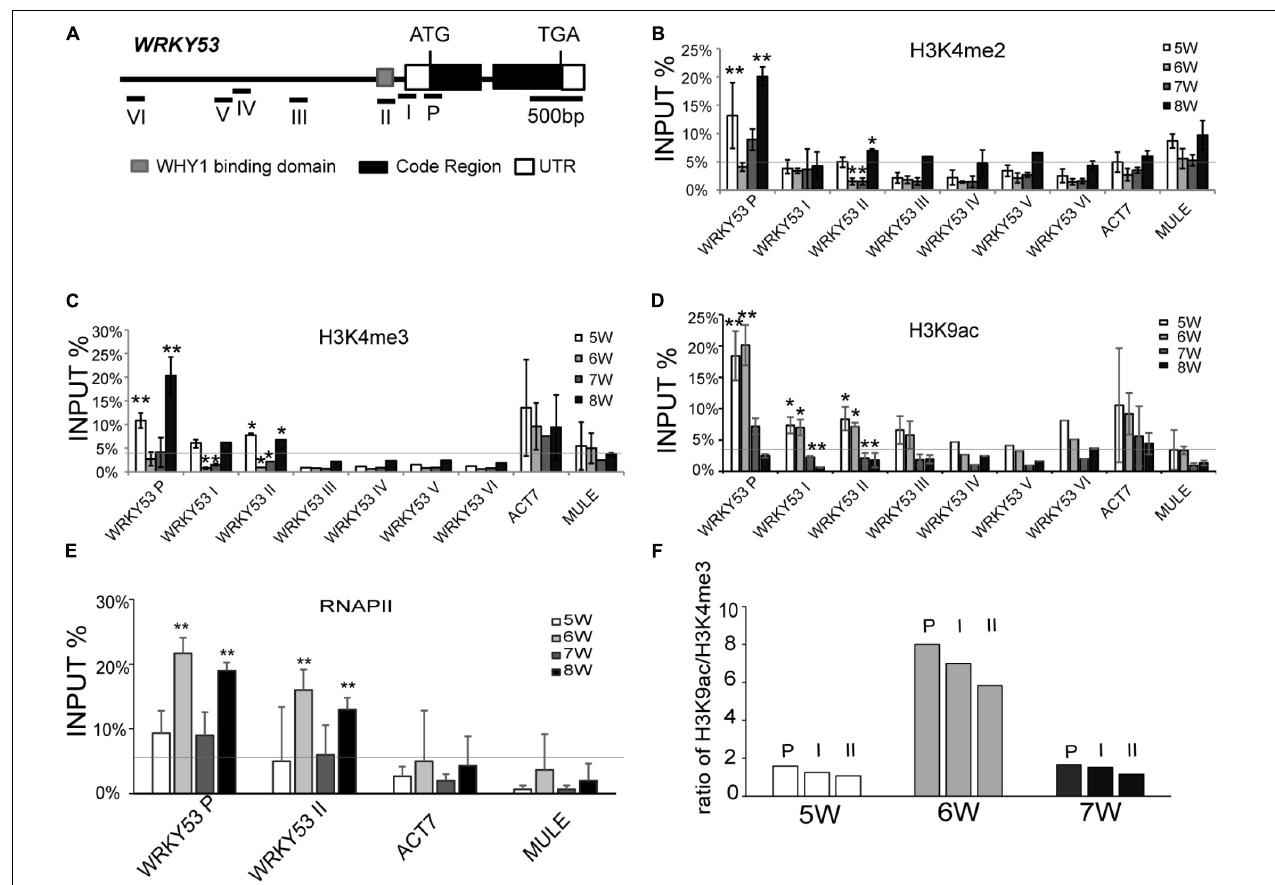
FIGURE 1 | Histone modification and RNAPII occupancy at the promoter regions and translation start region of WRKY53. (A) Schematic diagram of the genomic structure of the WRKY53 gene. The lines with number represent qPCR amplicons in different regions of WRKY53 gene. Gray box, black box, and blank box represent WHIRLY1 binding domain (gray), exon (black), and untranslated regions (blank). (B–E) ChIP analyses of changes in H3K4me2 (B) , H3K4me3 (C) , H3K9ac (D) levels, and RNAPII (E) occupancy at different regions of WRKY53 from 5 th to 8 th week. The antibodies used for ChIP were optimized ( Supplementary Figure S2 ). The quantitative PCR was performed with primers (I–VI) around the predicted WHIRLY1 binding sites on the promoter of WRKY53 and primer (P) covered the 5 (cid:48) untranslated region and translational start region of WRKY53 ( Figure 2 ) (Ay et al., 2009). ACT7 ( Actin-related gene 7, AT5G09810 ) and MULE ( Mutator-like transposable element, AT2G15810 ) were analyzed as controls. The relative level was normalized to INPUT DNA. Three biological replicates and three technique replicates were used to analyze. Error bar show the SD ( n = 3 × 3). Asterisk indicates significant differences ( ∗ P < 0.05 and ∗∗ P < 0.01) based on Student’s t -test. (F) Alteration of ratio of H3K9ac/H3K4me2-3 at different regions of WRKY53 from 5 th to 7 th week compared to occupancy of WHIRLY1 and transcripts level of WRKY53